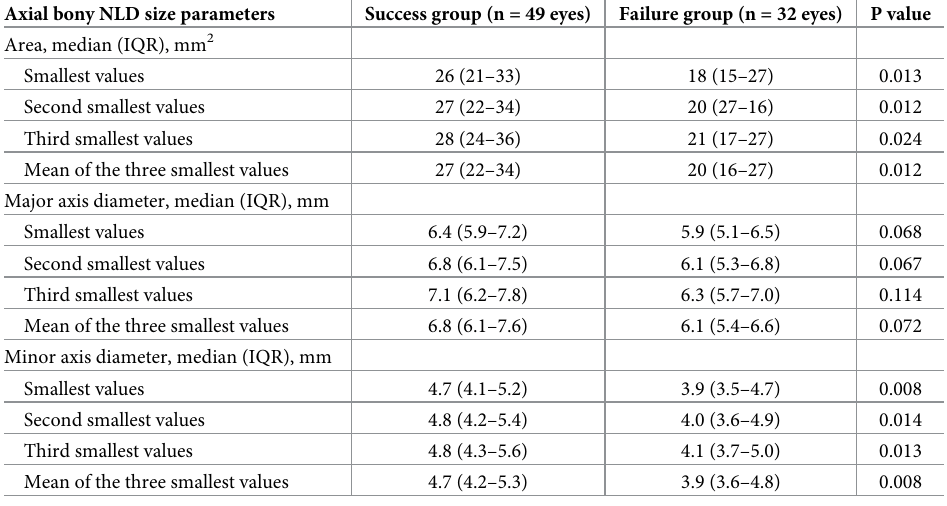
Table 2. Comparison of the axial bony nasolacrimal duct size parameters between the success and failure groups after nasolacrimal silicone intubation.